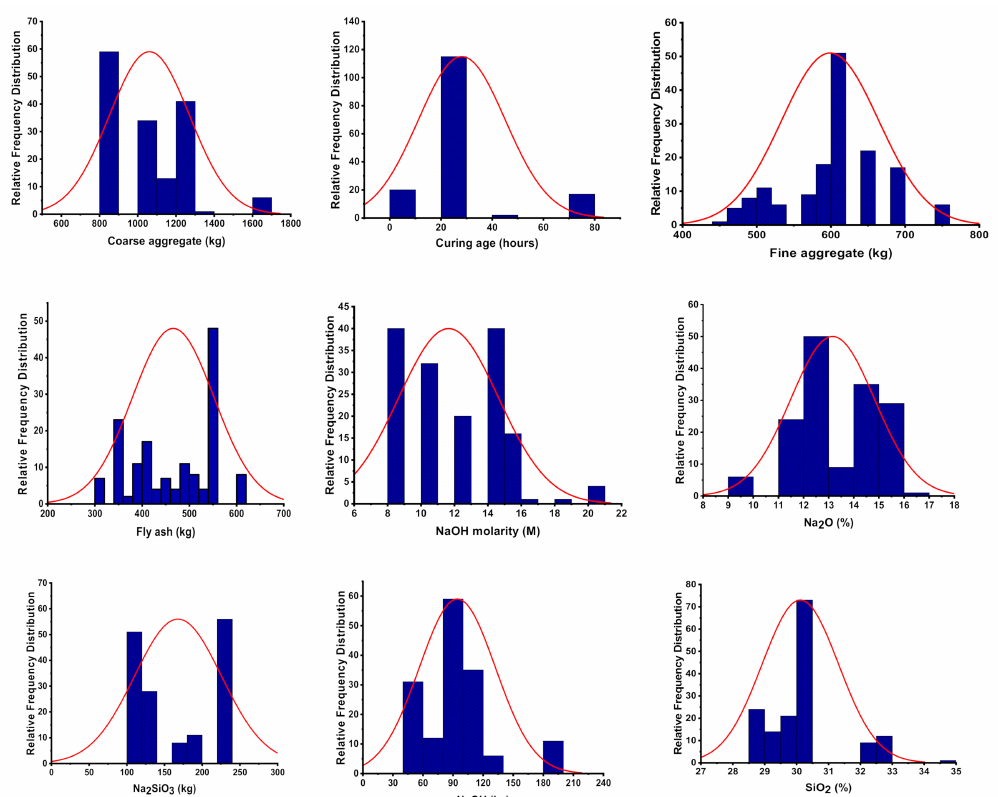
Figure 2. Input parameter’s relative frequency